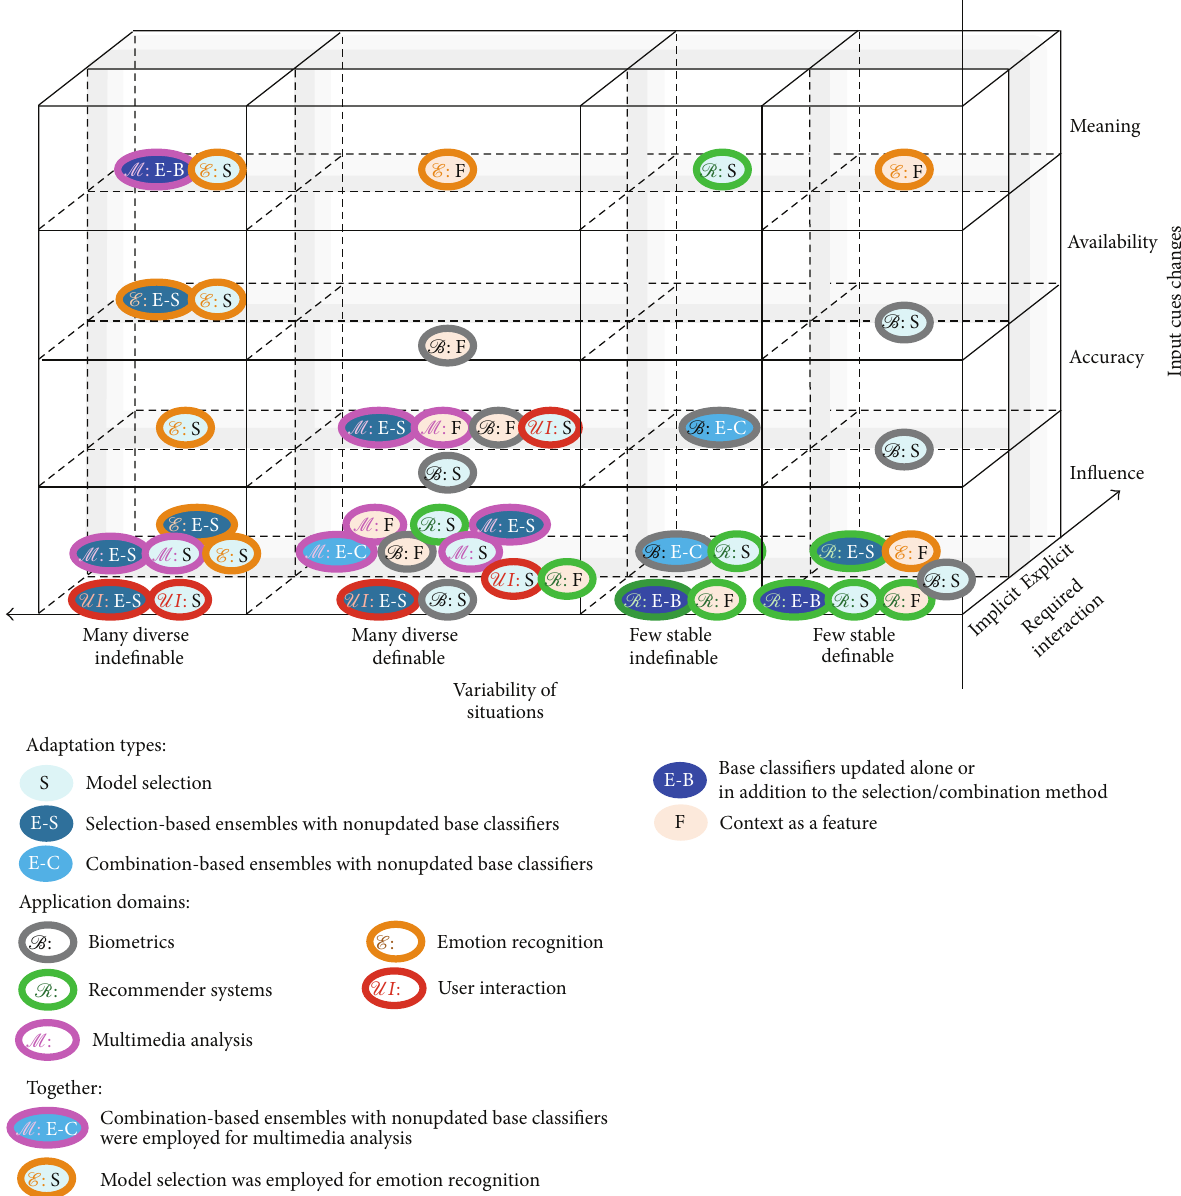
Figure 3: Lightweight adaptation summary (Section